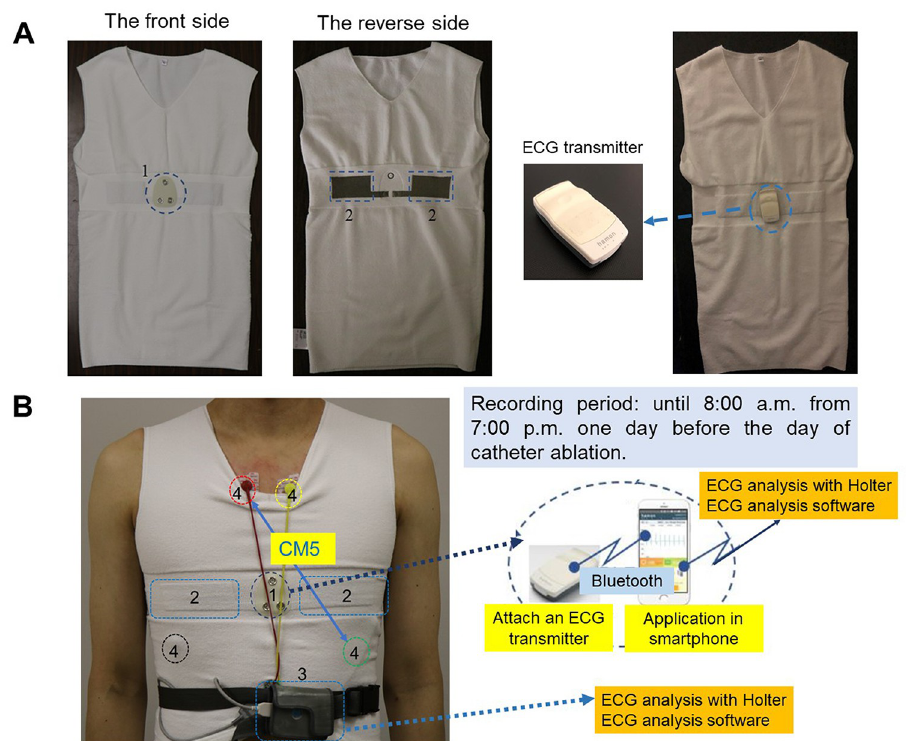
Fig 1. The structure and ECG acquiring systems of a wearable electrode embedded in an undershirt. (A) The structure and ECG acquiring systems of wearable electrodes. Left two panels show the front and reverse side of a wearable electrode. Right two panels show an ECG transmitter attached to an undershirt. (B) The method to record and send ECG using a wearable electrode and Holter ECG simultaneously. The explanation of components of a wearable electrode and Holter ECG: (1) The part which is connected to the ECG transmitter on an undershirt; (2) Silver textile electrode parts embedded in an undershirt; (3) Holter monitor; (4) ECG patch of Holter monitor. Abbreviations: ECG, electrocardiogram.